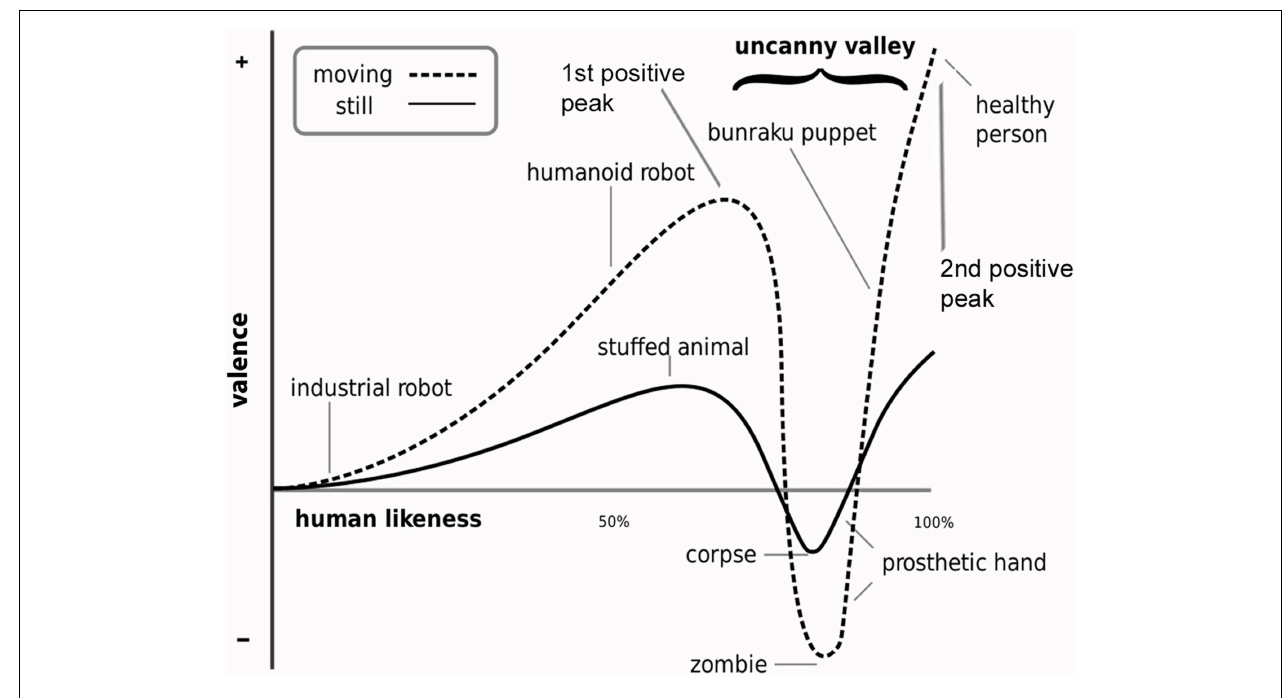
counterpart (i.e., at the first positive peak).This difficulty results in a sharp negative peak in the valence of affective experience that Mori describes as including feelings of eeriness and the uncanny (i.e., uncanny valley).This uncanny effect is thought to be stronger for objects in motion (illustration from MacDorman,